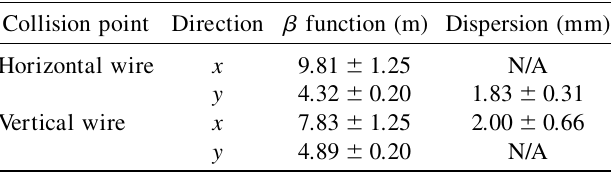
TABLE III. Summary of (cid:19) function and dispersion measurements.